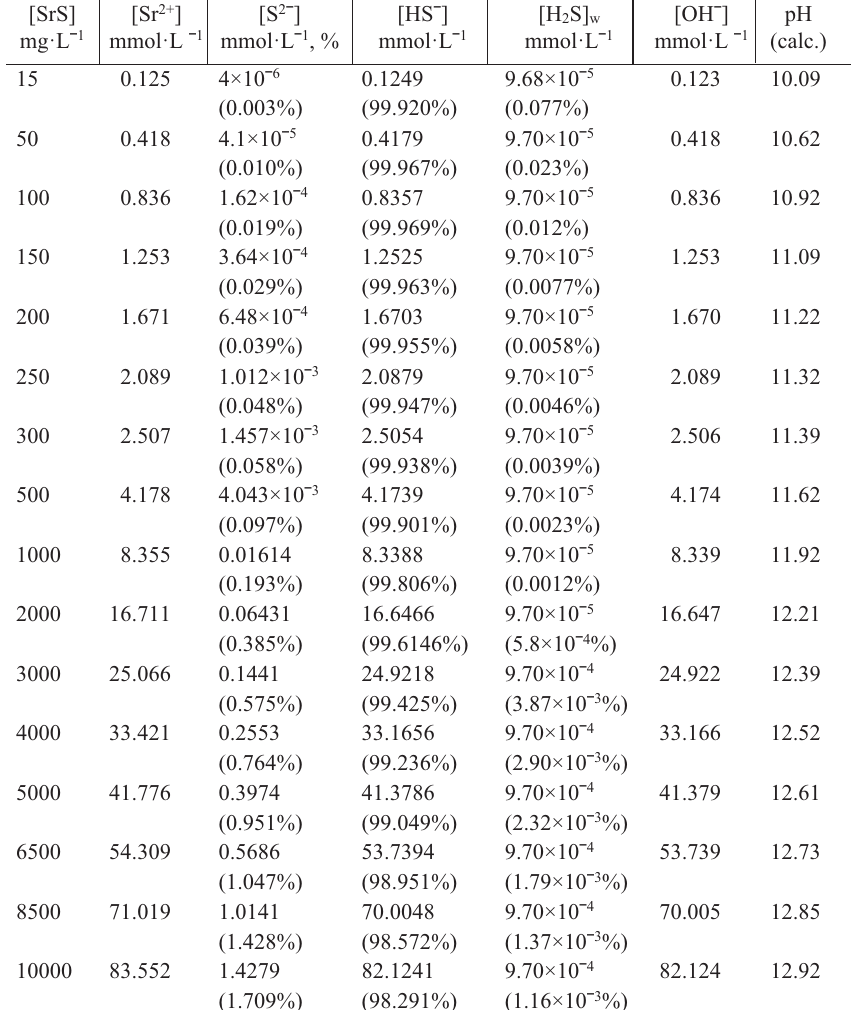
Table 1. Calculated concentration of formed ions, molecules and pH in the equilibrium system of H 2 O−SrS (0.125−83.552 mM), where K a1 = 1.041∙10 –8 mol·L –1 ; K a2 = 1.202∙10 –15